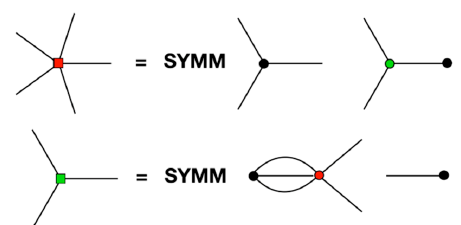
Figure 3. Representation of the multipole field terms for the interaction in Figure 1. The spokes radiating from coloured squares represent multipole fields tensors, of rank given by their number of spokes. The star with the central red square represents the rank-5 field tensor on the i site, and the star with the central green square represents the rank-3 field tensor on the j site.